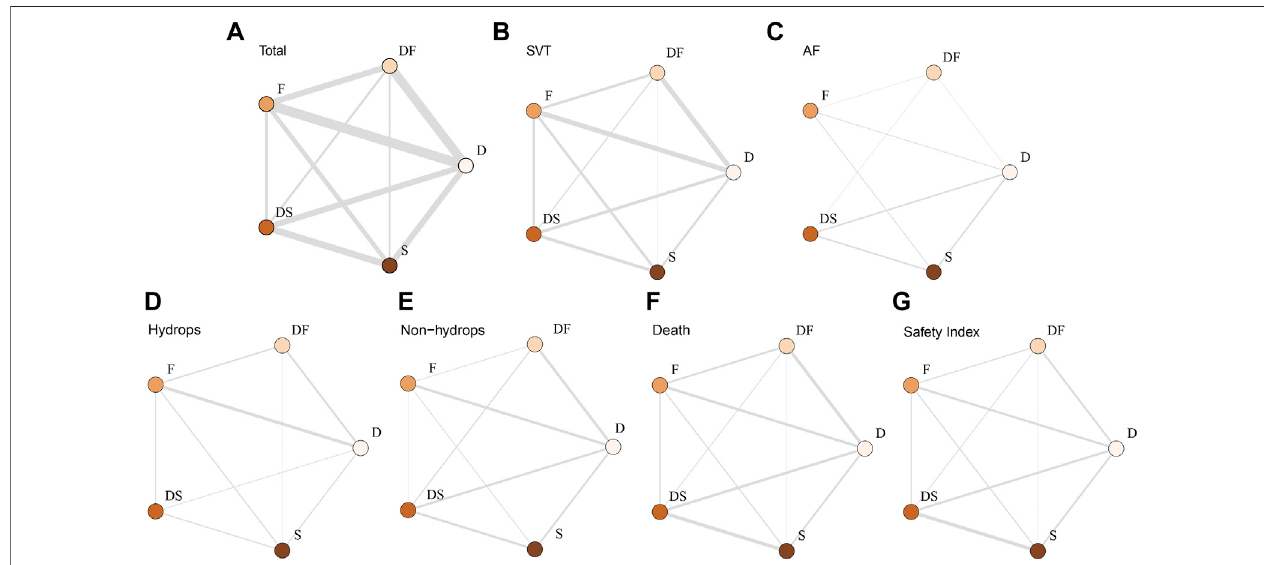
FIGURE 2 | Network plot of the enrolled analyses. The network plots represent comparison sizes between two regimens, with edge thickness representing the number of related studies. (A) Total group. (B) SVT group. (C) AF group (lacking any direct comparisons between F and DS). (D) Hydrops group (lacking any direct comparisonsbetweenDFandDS). (E) Non-hydropsgroup(lackinganydirectcomparisonsbetweenDFandDS). (F) Deathrateinthetotalgroup. (G) Safetyindexinthe total group. D, digoxin monotherapy; DF, digoxin and fl ecainide combination therapy; DS, digoxin and sotalol combination therapy; F, fl ecainide monotherapy; S, sotalol monotherapy; SVT, supraventricular tachycardia; AF atrial fl utter.